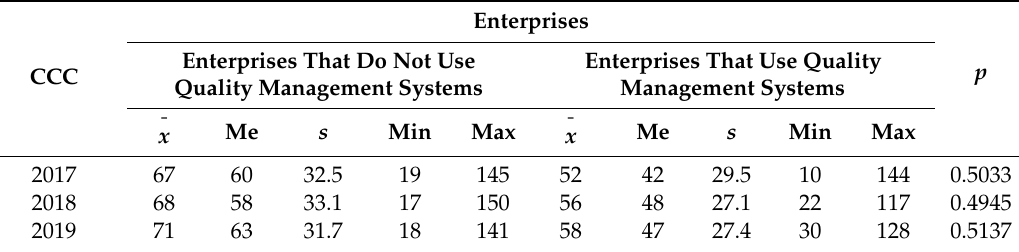
Table 4. Cash conversion cycle (CCC in